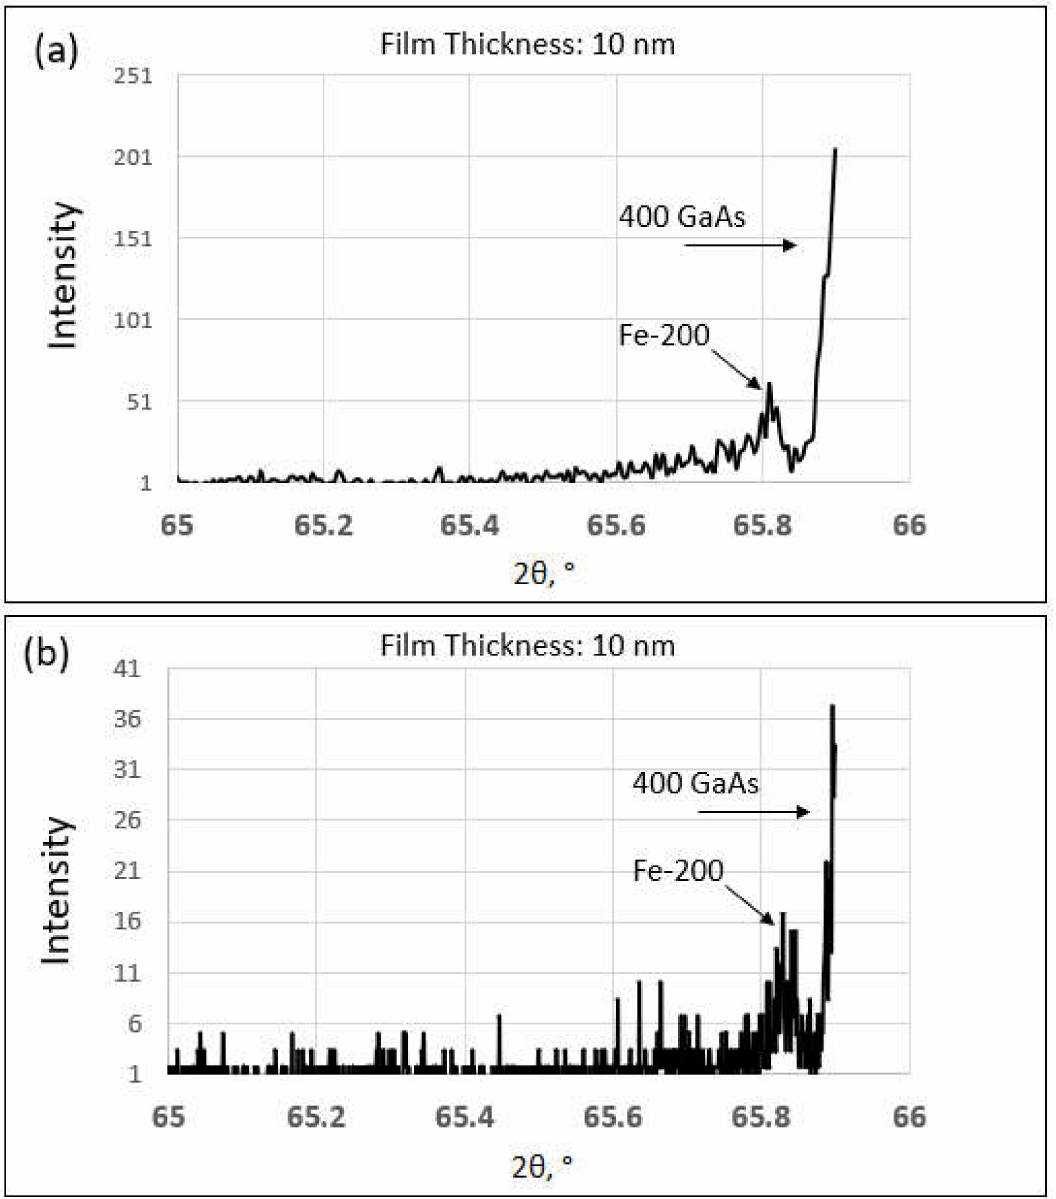
Figure 2. ( a ) XRD of 10-nm-thick Fe film deposited at room temperature on (001) AlGaAs, showing the 002 peak, corresponding to a lattice parameter of 2.83 Å. ( b ) XRD of 10-nm-thick Fe film deposited at 175 ◦ C on (001) AlGaAs, showing the 002 peak, corresponding to a lattice parameter of 2.833 Å. As the misfit of bcc δ -Fe on (001) AlGaAs was approximately 0.5% for 10 nm thin